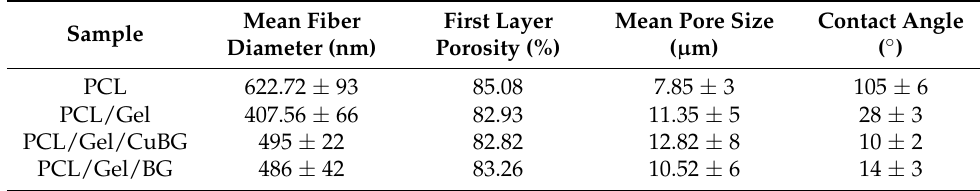
Figure 2. Membrane characterization. ( a ) SEM images of the electrospun nanofibrous membranes. ( b ) FTIR spectra of scaffolds ( c ) SEM images of membranes after 28 days soaking in SBF ( d ) Cu 2+ ions released in water from the PCL/Gel/BG, PCL/Gel/CuBG hybrid nanofiber scaffolds with spectto incubation time. Table 3. Physical properties of nanofiber